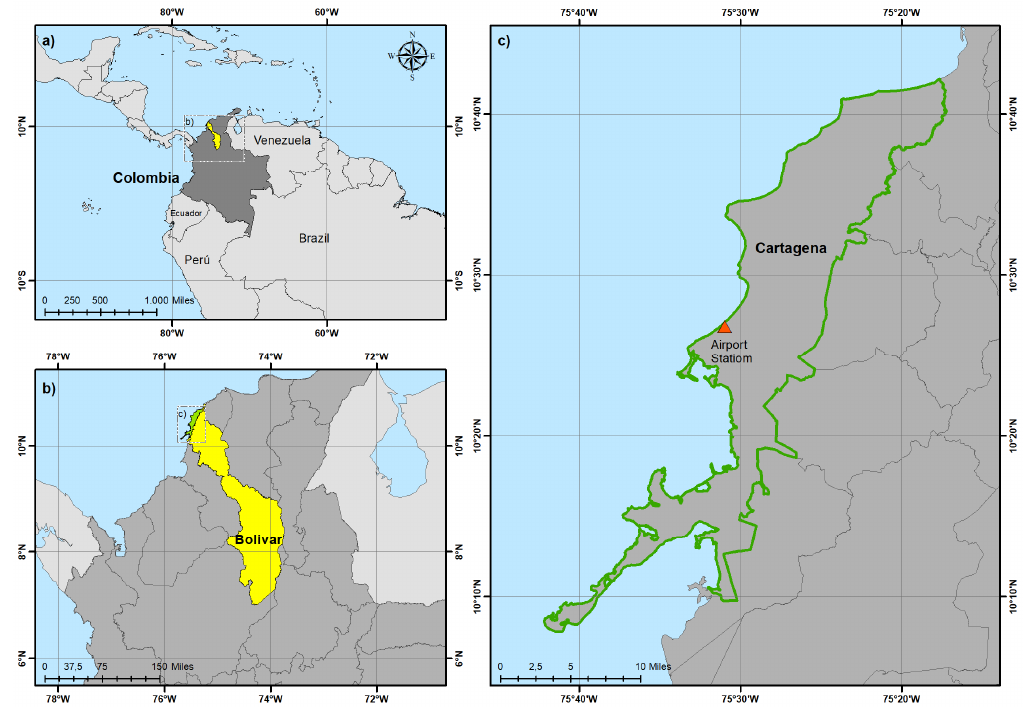
Figure 1. Location of study area: ( a ) Colombia; ( b ) Bolivar department (in yellow); ( c ) City of Cartagena and location of Rafael Núñez Airport Station.